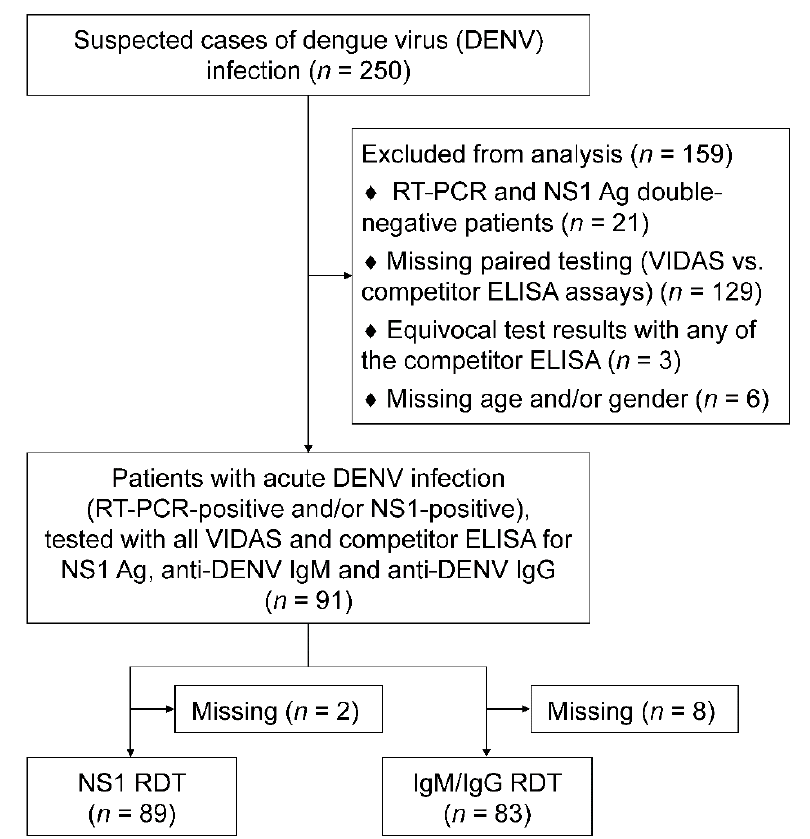
Figure 1. Study flow diagram. Out of 250 suspected cases of DENV infection, 91 identified as acute DENV infection (RT-PCR-positive and/or NS1 antigen-positive) were tested with the three VIDAS ® prototypes and competitor assays (ELISA and RDT). Of these 91 samples, 89 and 83 were also tested with a RDT specific for NS1 and IgM/IgG, respectively. Abbreviations: Ag, antigen; DENV, dengue virus; ELISA, enzyme-linked immunosorbent assay; IgM, immunoglobulin M; IgG, immunoglobulin G; NS1, non-structural protein 1; RDT, rapid diagnostic test; RT-PCR, real-time reverse-transcription polymerase chain reaction.